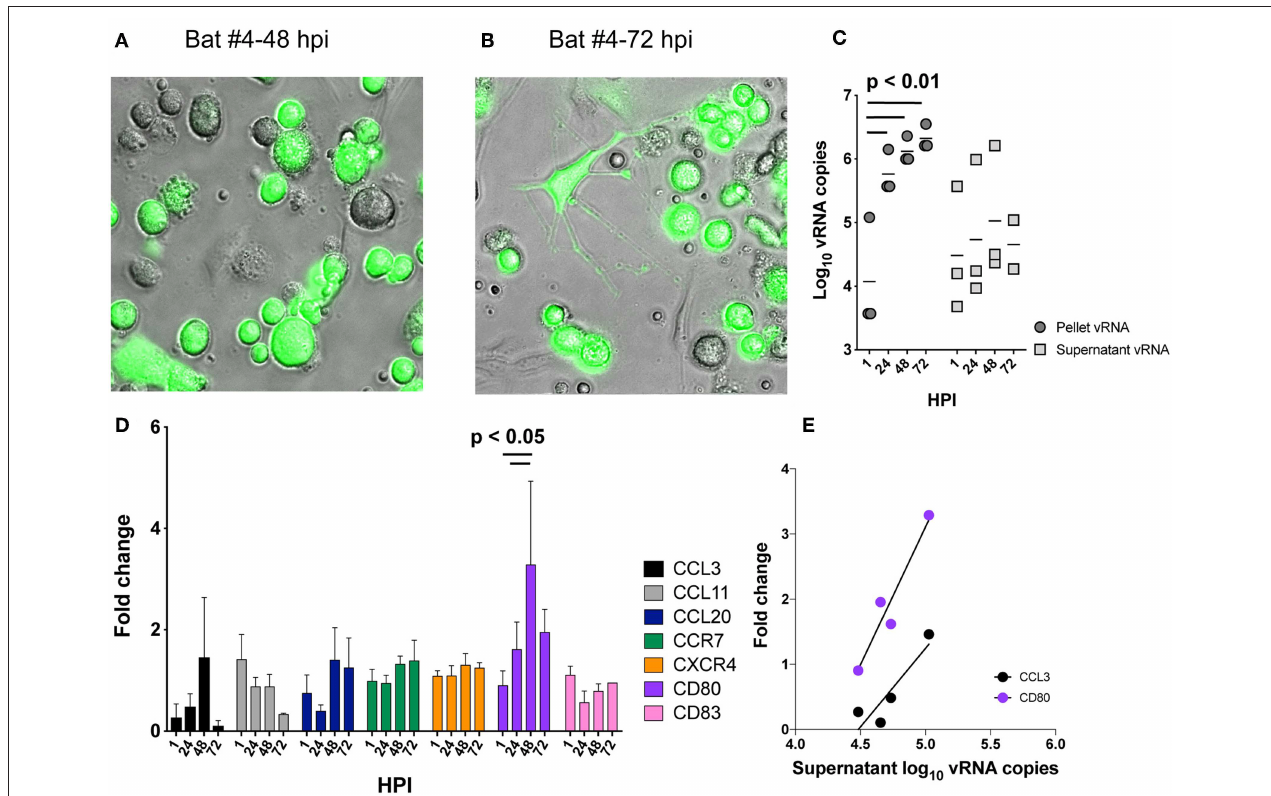
FIGURE 6 | Response of bat-BMDC to EBOV infection. BMDC cultures from bat#4 were infected with GFP-tagged EBOV and cultures were visualized with an EVOS FL Imaging System at 48 (A) and 72h post infection (HPI) (B) . Day 6–10 BMDC cultures from three separate bats (#3, #4, and #43) were inoculated with EBOV at an MOI of 3 for 1h and supernatant and cell pellets were collected at 1, 24, 48, and 72 hpi and subjected to RNA extraction to quantify viral copies. The log 10 vRNA copies/100 µ l of supernatant (dark-gray circles) or cell pellet (light-gray squares) are shown for each bat-BMDC culture individually (C) . RNA isolated from cell pellet was further subjected to qPCR assays measuring host transcripts and the relative fold changes in gene expression are shown for CCL3, CCL11, CCL20, CCR7, CXCR4, CD80, and CD83 in (D) , a bar graph showing mean values and standard deviation for the three bat-BMDC cultures tested. Relative fold change was calculated by (gene absolute copy number in infected cultures/gene absolute copy number in matched and uninfected BMDC cultures) where all values were normalized to the housekeeping gene RPL13. Significant correlations between viral RNA copies and fold change in host gene expression was determined by Pearsons test and the linear regression defining the correlations are shown in an xy plot (E) . Mixed-effects model with Tukey multiple comparisons posttest determined significance in (C,D)